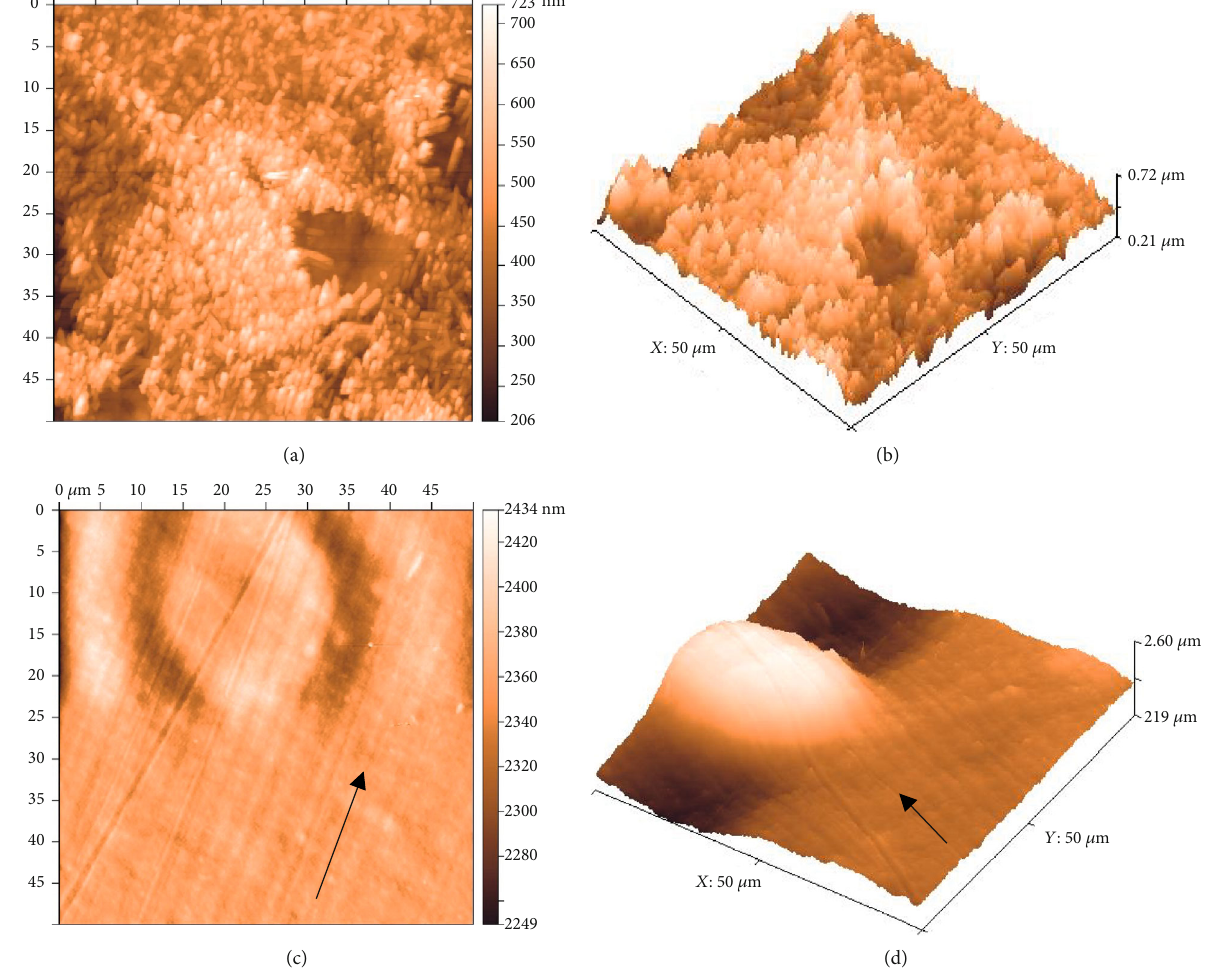
Figure 3: AFM micrograph of CNC fi lm formed with a 5 wt% CNC sample. (a, c) 2D-AFM micrographs of the sample and (b, d) 3D-AFM micrographs of the same